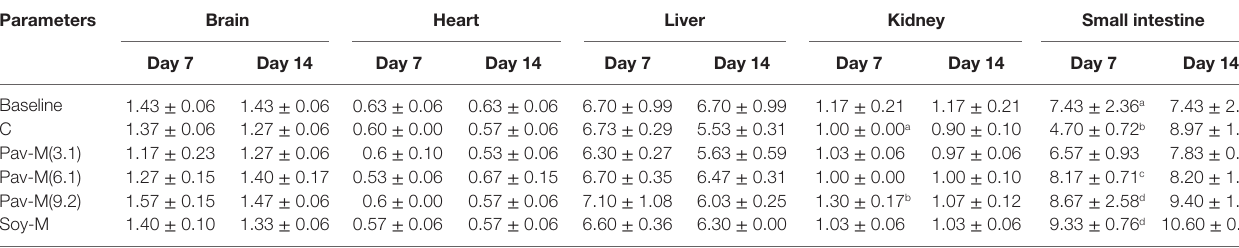
TaBle 3 | Changes in weight of organs of rats administered with pro-milk extract from Adenanthera pavonina and soy bean. Parameters